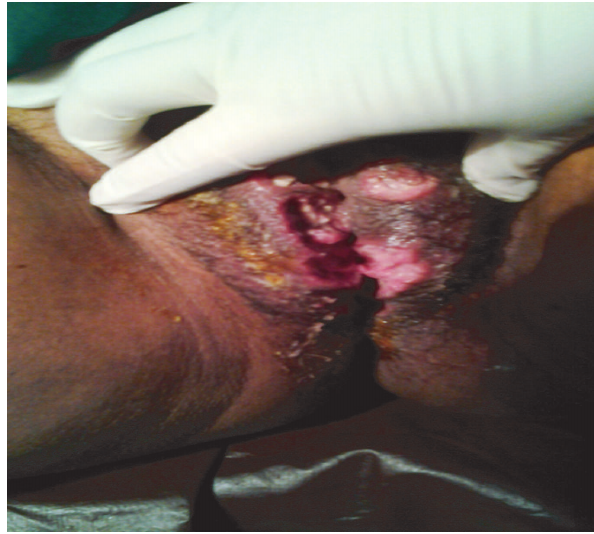
Fig 1. Extensive confluent ulceration with necrotic base on both sides of labia majora and minora(cid:13) After consultation with dermatologist, we treated the patient with Inj. dexamethasone 5 mg 12 hourly for 5 days followed by oral prednisolone for 2 weeks, tablet dapsone 100 mg once daily, tablet colchicine 0.6 mg 12 hourly, injection ceftriaxone 1 gm twice daily (to treat secondary infection and urinary tract infection), NSAID for pain. After 3 days patient started improving significantly and after 6 days she was discharged from hospital with oral prednisolone for 2 weeks, colchicine for 2 weeks, dapsone for 20 days and cefixime for 7 days. Patient came for follow-up 7 days and 17 days after discharge. After 17 days size of ulcer was very small with minimum pain. Erythema nodosum disappeared within 7